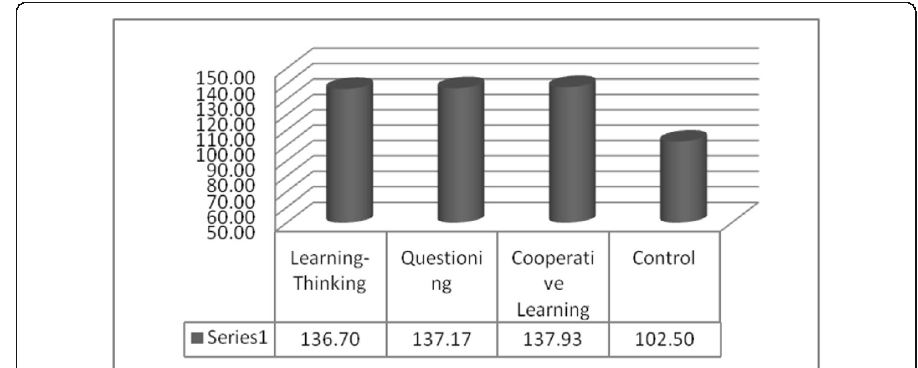
Fig. 2 Means on post-test autonomy